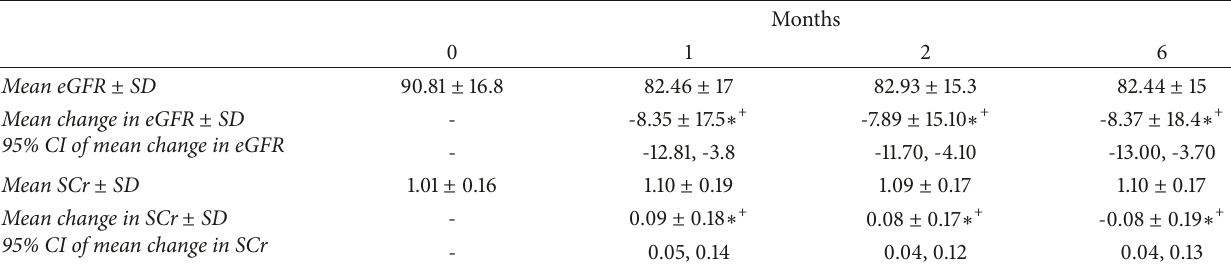
Table 6: Changing patterns of estimated glomerular filtration rate and serum creatinine over 6-month follow-up of study participants in TASH, October 2017 [n =